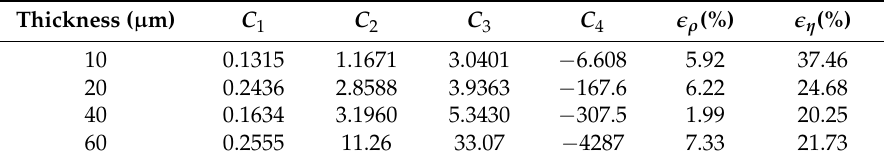
Table 1. Computed coefficients in the calibration process of the 1500 µ m-long, 900 µ m-wide cantilevers operating in the second order roof tile-shaped mode. Errors of the calibration method in the determination of the density (cid:101) ρ and viscosity (cid:101) η are also